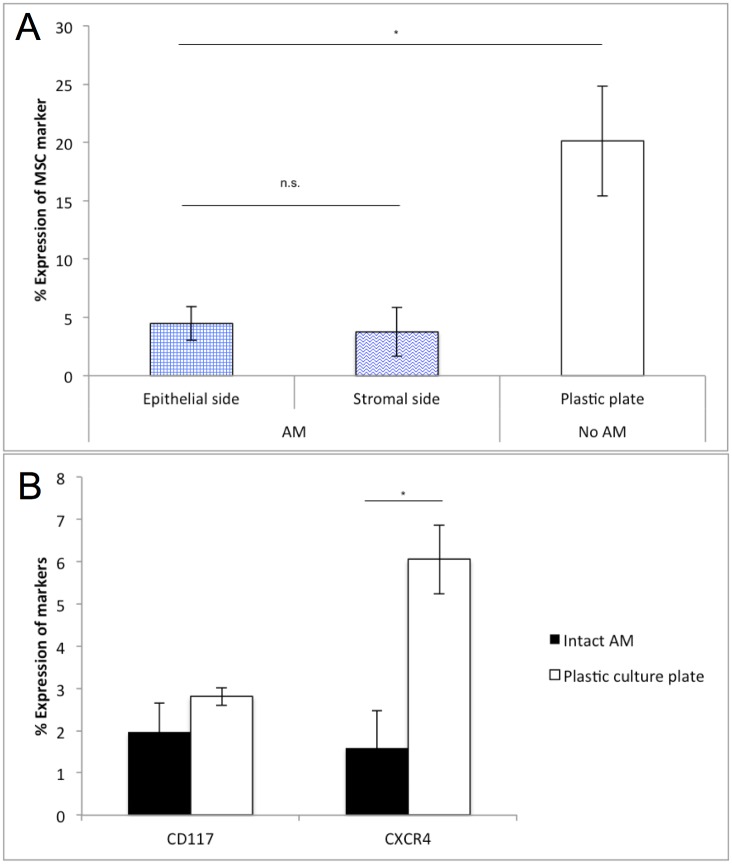
Expression of MSC markers (CD73/CD90/CD105+ and CD45-) and putative LESC surface markers (CD117 and CXCR4) in limbal explant cultures grown on both sides of amniotic membrane versus cultures cultivated on plastic culture plates.(A,B) The plots of the mean percentages of positive cells ± SEM for the tested markers are shown (A: ANOVA; B: Student two-tailed t-test; * p < 0.05; n. s. = not statistically significant). (A) On the epithelial side of the AM 4.5 ± 1.4% (n = 4) were positive and on the stromal side of the AM 3.8 ± 2.1% (n = 6) cells were positive for the mesenchymal stem cell marker. A statistically significant higher expression rate was found in primary limbal explant cultures (n = 13; 20.1 ± 4.7%) cultivated on plastic culture plates (ANOVA; p = 0.04). (B) CD117 was similarly expressed in limbal cell cultures cultivated on AM (n = 3; 2.0 ± 0.7%) compared to cultures cultivated on plastic culture plates (n = 3; 2.8 ± 0.2%; t-test; p = 0.2), CXCR4 expression was however significantly higher in cultures cultivated without AM (6.1 ± 0.8% vs. 1.6 ± 0.9%; t-test; p = 0.03). (MSC: mesenchymal stem cell; LESC: limbal epithelial stem cells.)